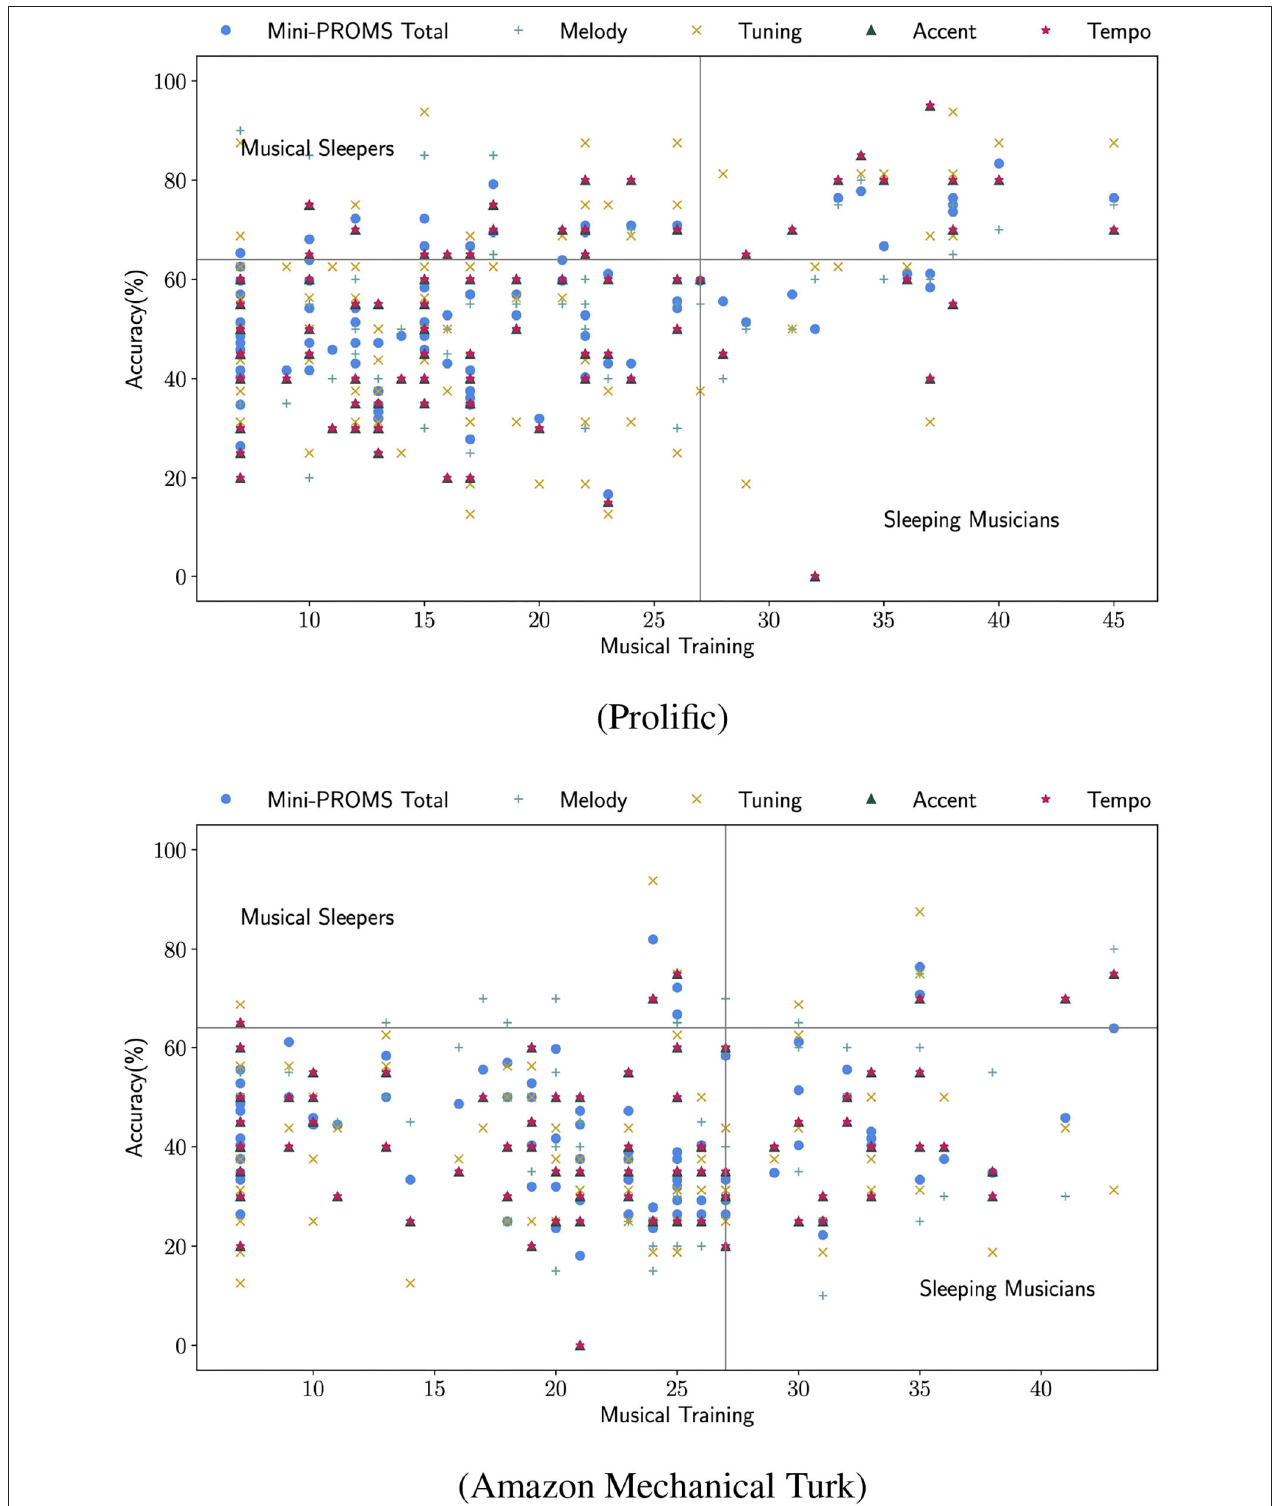
FIGURE 3 | Musical Training (GMSI) and Performance on Mini-PROMS (acc%).